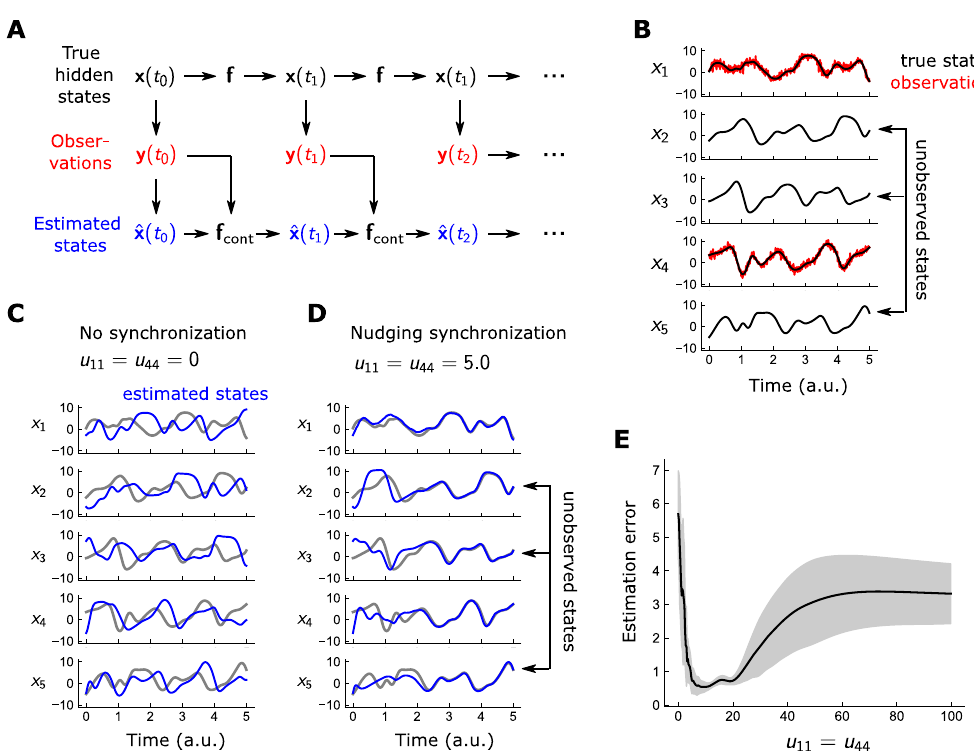
Fig 1. Nudging synchronizes estimate to observations with lax parameter tuning. A: Hidden states x evolve temporally under the controlled dynamics via _ x ¼ f ð x Þ , where f is the sum of model dynamics and an external data-driven control cont cont term. The control feeds back the difference between x and the observations y , for measured states; it is absent in unmeasured states. B: Ground-truth trajectories and observations Lorenz96 system in 5 dimensions; only x 1 and x 4 are observed. Measurements obtained by adding uncorrelated noise with σ = 1 at each timestep. C and D: True (black) and estimated (blue) trajectories of the Lorenz96 system, for no nudging control (C) and with x 1 and x 4 controlled with strength U 11 = U 44 � u = 5 (D). The controlled system synchronizes closely to ground truth for both the observed unobserved variables. E: Mean-squared ffiffiffiffiffiffiffiffiffiffiffiffiffiffiffiffiffiffiffiffiffiffiffiffiffiffiffiffiffiffiffiffiffiffiffiffiffiffiffiffiffiffiffi P q of estimates as a function of control strength; near-minimal errors are achieved over a error 1 ND relatively wide range of u